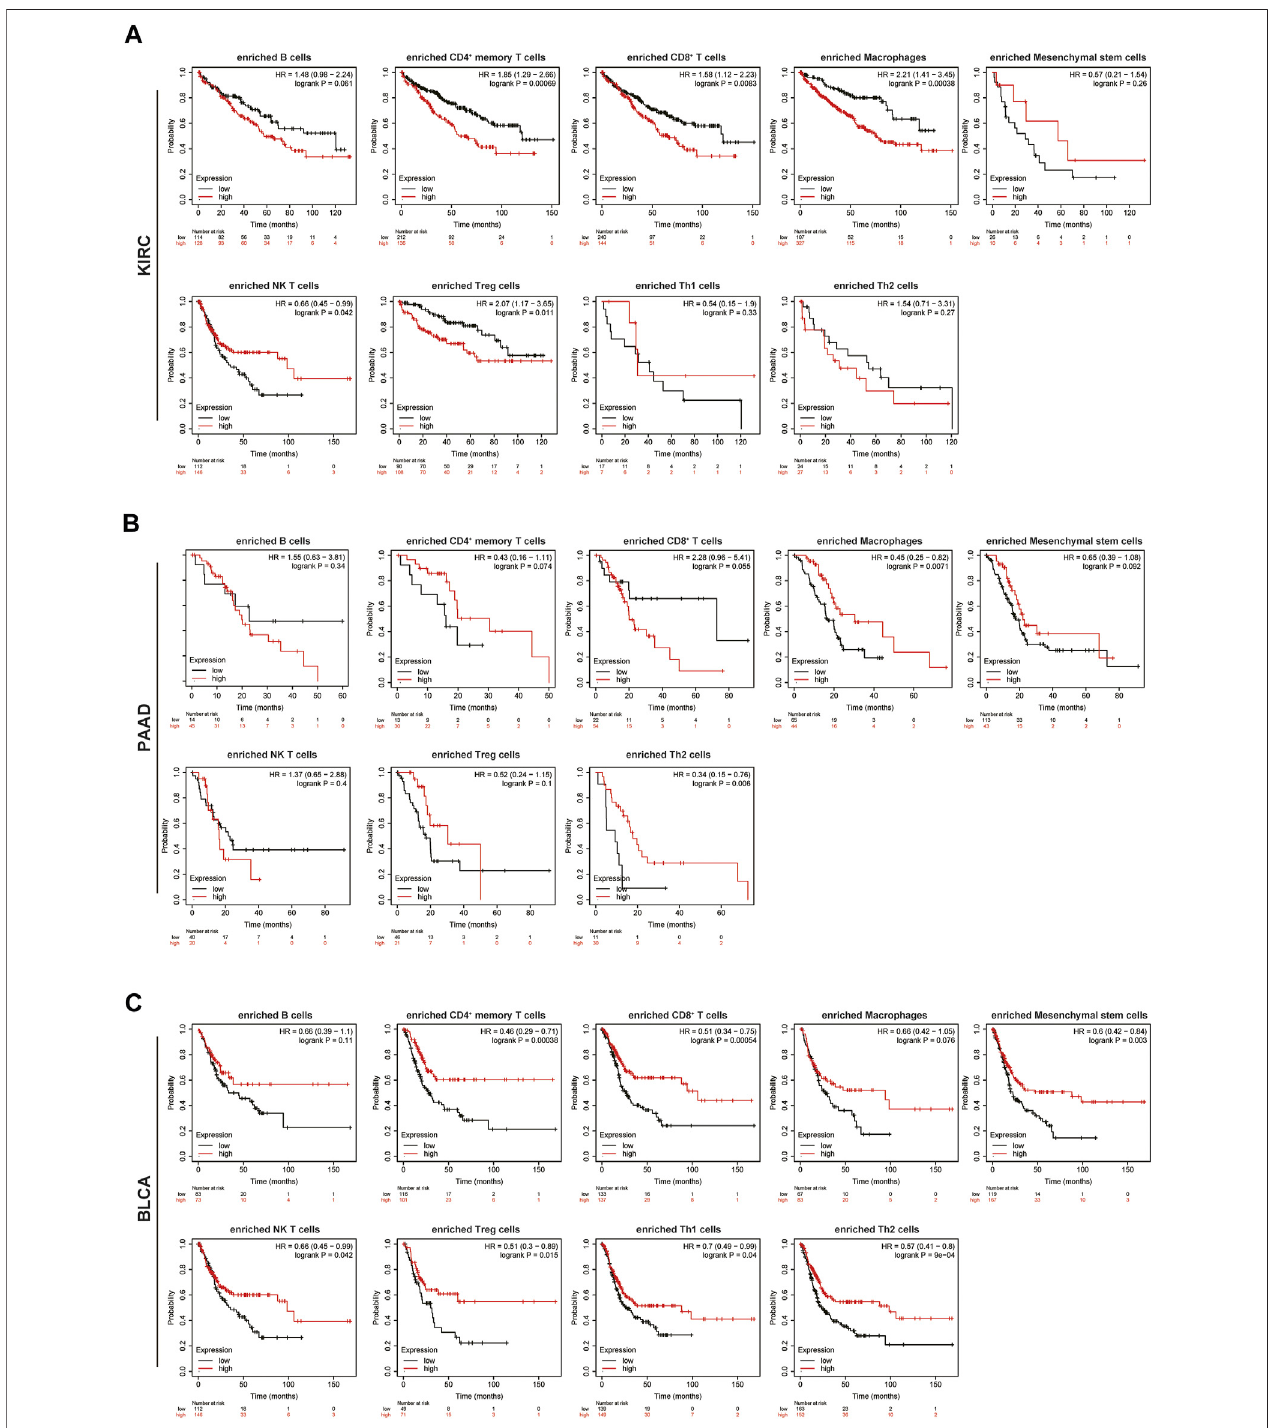
FIGURE 6 | Comparison of the Kaplan – Meier survival curves of overall survival (OS) showing the expression of TRPM2 in kidney renal clear cell carcinoma (KIRC), pancreatic adenocarcinoma (PAAD), and bladder urothelial carcinoma (BLCA) based on the differentially enriched immune cell cohorts. The association of the level of TRPM2 with OS was shown in KIRC (A) , PAAD (B) , and BLCA (C) patients based on the differentially enriched immune cell subgroups in the Kaplan – Meier plotter.